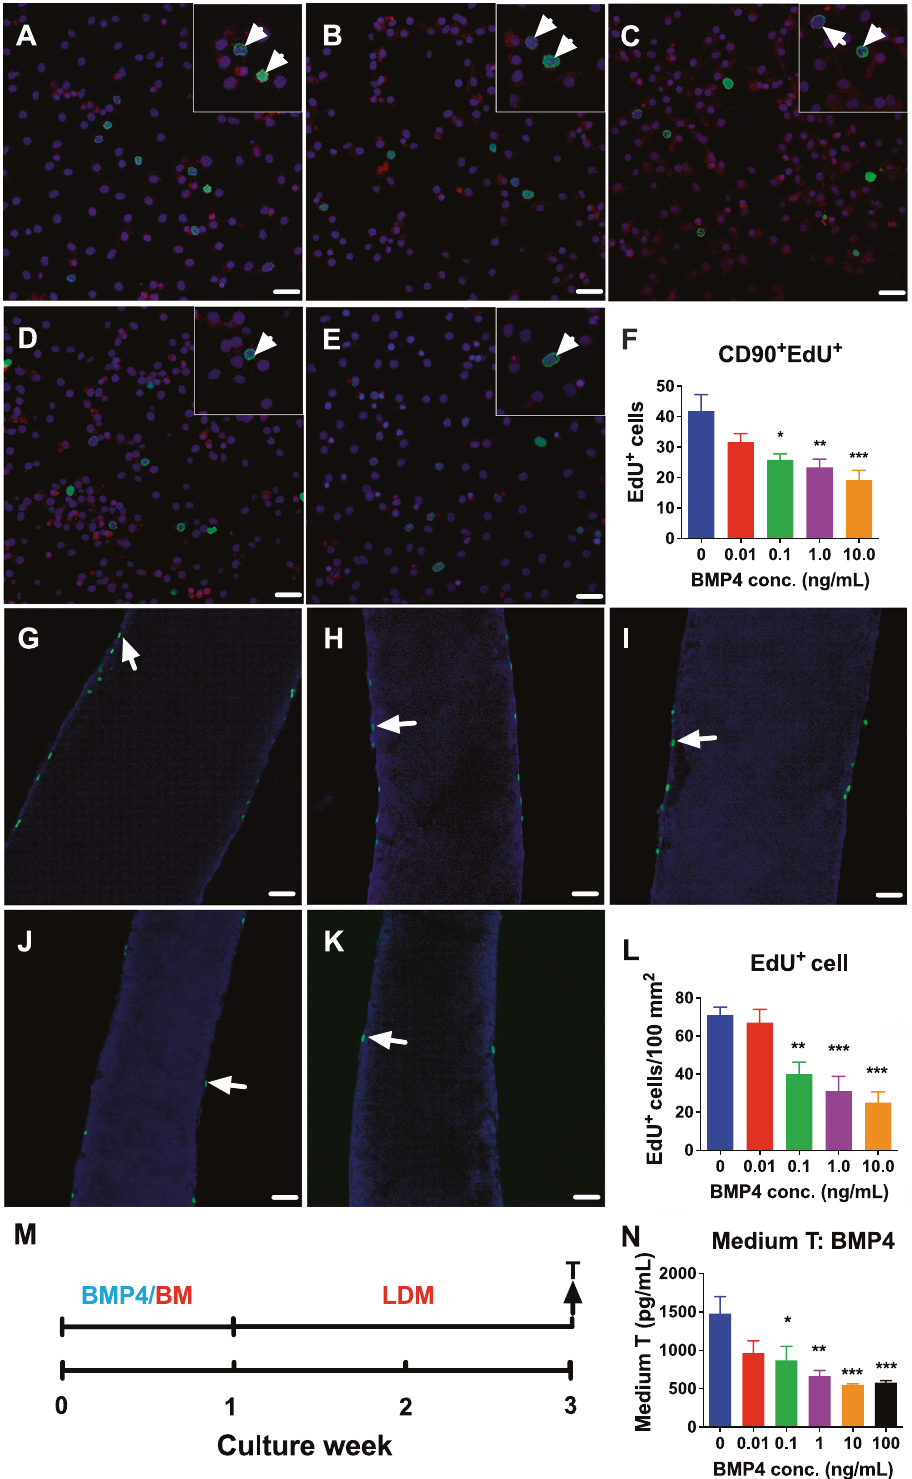
Fig. 4 The effect of BMP4 on stem Leydig cell (SLC) proliferation in vitro. A – F CD90 + SLCs were incubated with 0 ( A ), 0.01 ( B ), 0.1 ( C ), 1.0 ( D ), and 10.0 ( E ) ng/mL BMP4 for 24 h. F Quantitative data for EdU labeling index, mean ± SEM, n = 6. White arrowheads indicate EdU + SLCs: CD90, red membrane; EdU, green nucleus; DAPI, blue nucleus. Bar = 50 μ m. SLCs on ST seminiferous tubule (ST) surface treated with 0 ( G ), 0.01 ( H ), 0.1 ( I ), 1.0 ( J ), and 10.0 ( K ) ng/mL of BMP4 for 7 d and then EdU (green) was incorporated; L Quantitative results for EdU + SLCs per square centimeter, mean ± SEM, n = 6. White arrows indicate EdU + SLCs. Bar = 50 μ m. M ST culture protocol; N Medium testosterone (T) levels after BMP4 treatment in the fi rst week; Mean ± SEM, n = 6. * P < 0.05, ** P < 0.01, and *** P < 0.001 indicate signi fi cant differences compared to control (0 ng/mL